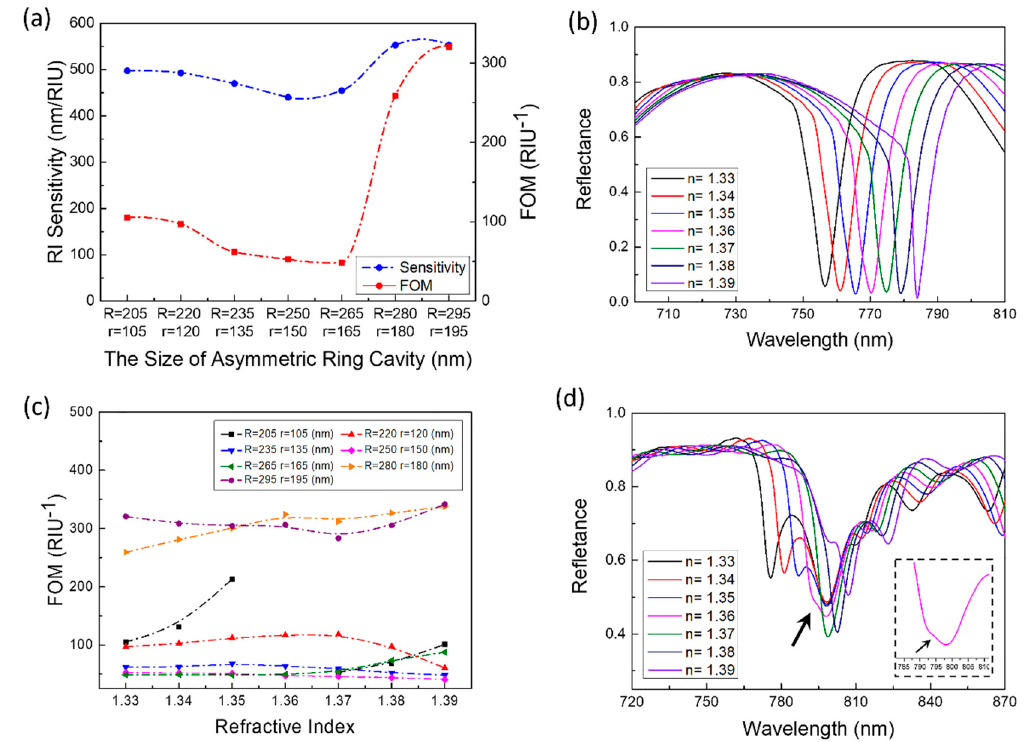
Figure 8. ( a ) The sensitivity and FOM (n = 1.33) changes with R and r . ( b ) When R = 265 nm and r = 165 nm, the reflectance spectrum of the sensor with the changes of the refractive index from 1.33 to 1.39. ( c ) The impact of R and r changes on FOM, when n = 1.33–1.39. (The dashed line connecting the data points is simply connected with a smooth curve for readers as a guide for an eye.) ( d ) When R = 205 nm and r = 105 nm, the reflectance spectrum of the sensor with the changes of the refractive index from 1.33 to 1.39. The inset is a partial spectrum when n = 1.36 and mode 2 where the arrow points are very weak, just bringing a slight fluctuation to the spectrum.